Question: Name the type of graph shown.
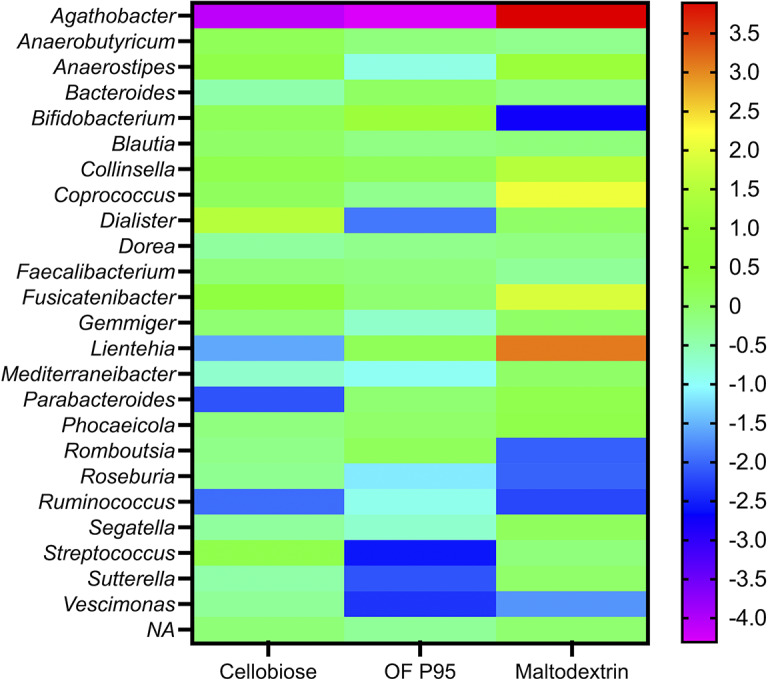
Answer: heatmap